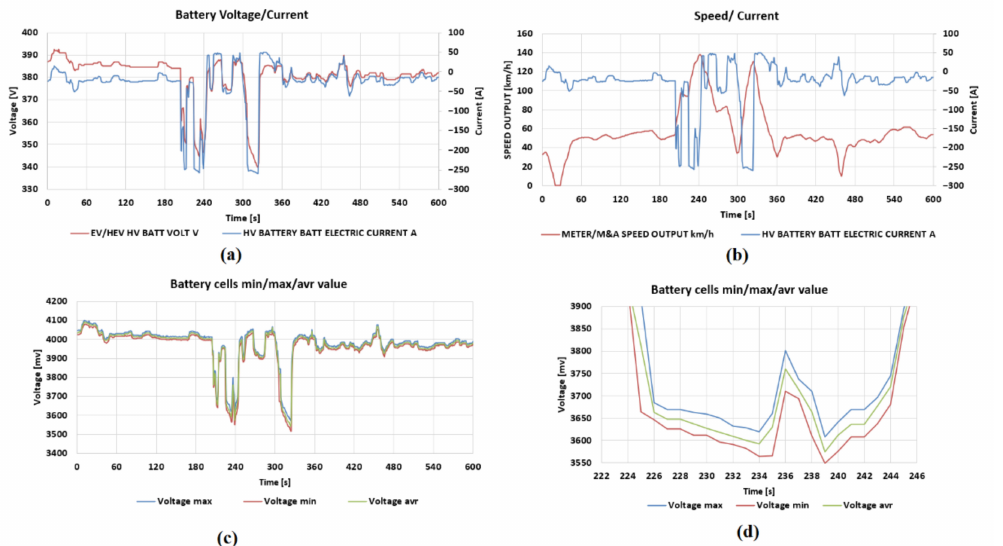
Figure 5. A demonstration of a rapid-test procedure on an electric vehicle: ( a ) load current and system voltage during the test; ( b ) current changes as a function of speed; ( c ) min/max and average values of the cell voltages during the test; ( d ) min/max and average values of the cell voltages for the high-load section: 222–246